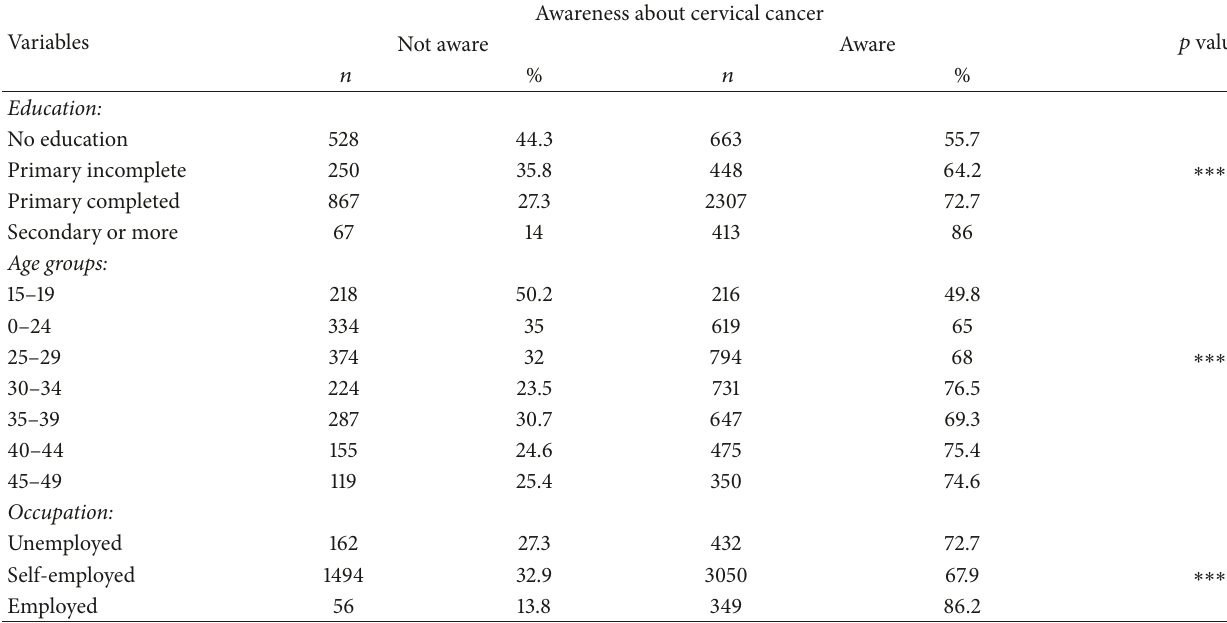
Table 1: The distribution by sociodemographic characteristics and awareness about cervical cancer.